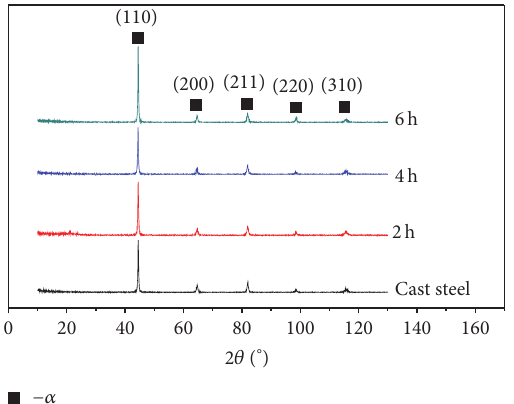
Figure 1: XRD pattern of the 1045 carbon steel without and with annealing at 873 K (600 ∘ C) with different time.